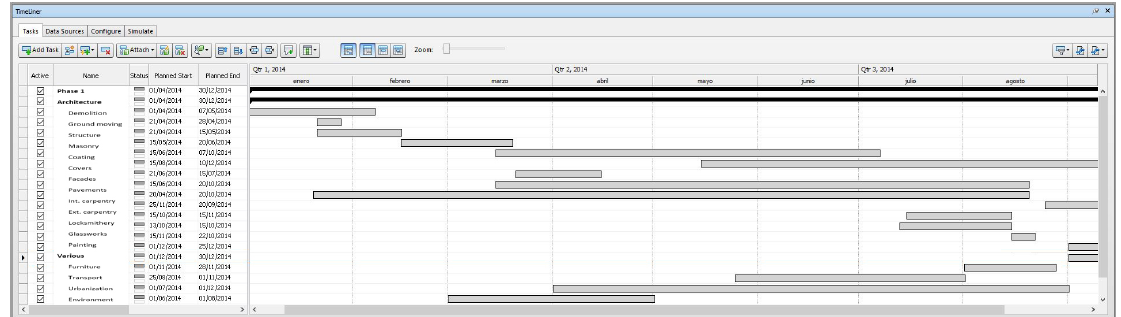
Figure 4. Possibility of immediate replanning in the Business Information Modelling (BIM) environment and access to real and truthful information in real time by all